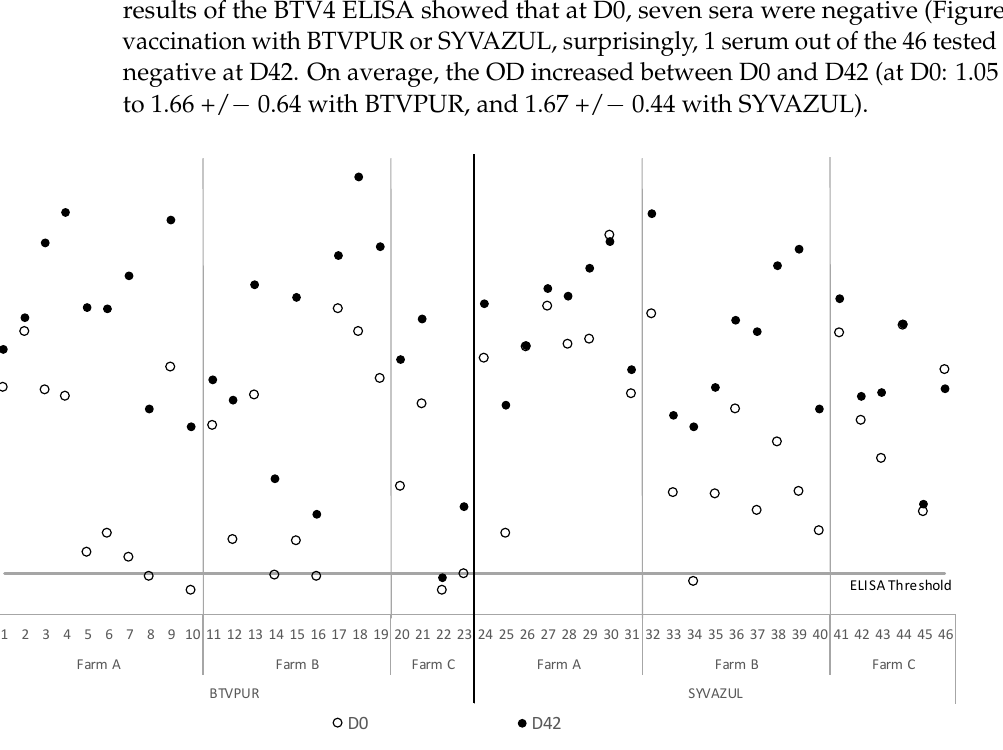
Figure 1. Double-antigen sandwich ELISA serotype 4-specific antibodies OD results from sera collected prior to D0 (white circle) and post D42 (black circle) booster vaccination with either BTVPUR or SYVAZUL. X axis represents the animals boosted with BTVPUR (1–23) and SYVAZUL (24–46). Horizontal line represents the cut-off value (threshold). Circles crossing the line are considered as negative results. Table 3. Average serum-neutralizing antibody (Nab) titer per farm and per serotype and difference between the average titers at D42 and D0 according to the vaccine used for boosting. Mean Titer at D0